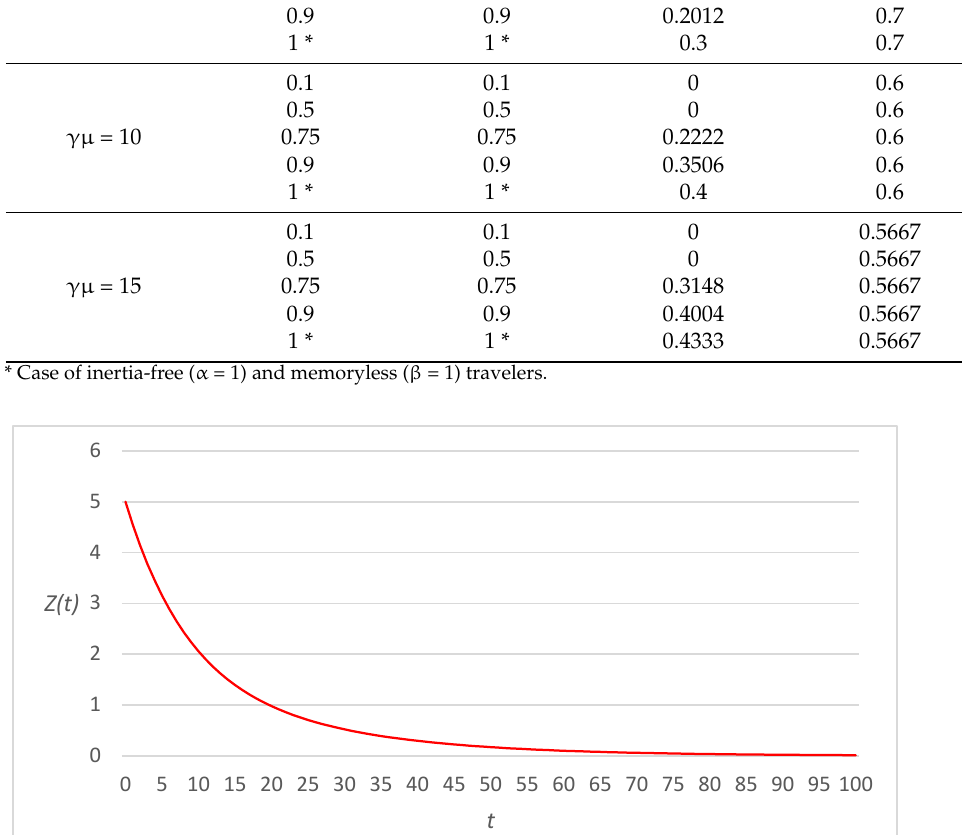
Figure 2. Time evolution of dynamical system for 𝛼 = 0.75;𝛽 = 0.75; 𝛾𝜇 = 10; 𝜑 = 0.23; 𝑍(0) = 1 (case of linear link cost functions).